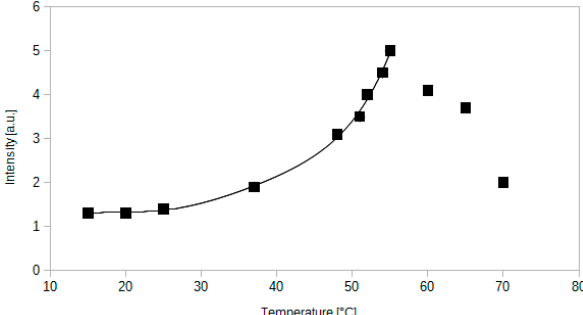
Figure 10. Dependence between the light intensity transmitted by an optical fibre sensor containing methyl red and the temperature. Measurement performed at 0.1% of CO 2 in air.